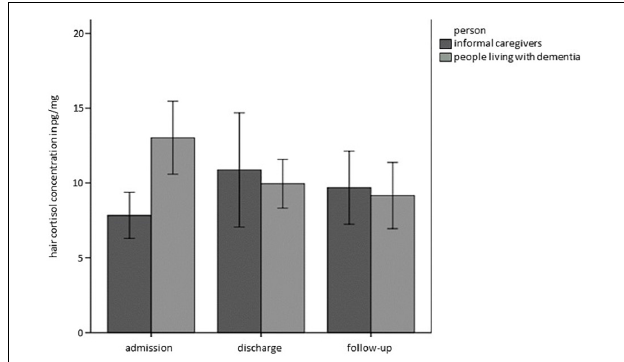
FIGURE 2 | Hair cortisol concentrations (HCC) over time separately for PwD and ICs. Error bars represent standard error of the